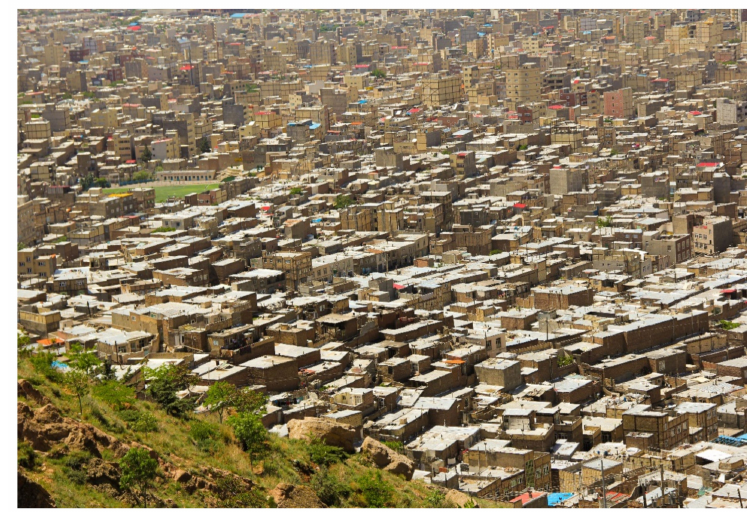
Figure 17. General condition of the unsuitable urban fabric in